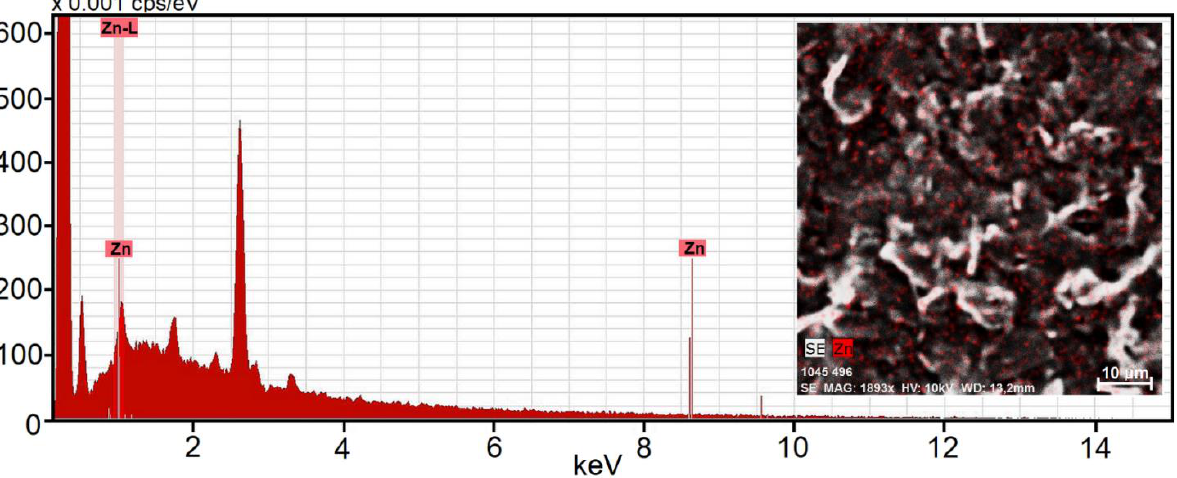
Figure 5. Energy dispersive X-ray spectrum of the screen-printed carbon electrode (type DRP-C110) covered with a thin layer of poly-4-hydroxybenzaldehyde and covalently bound ALP. The inset im- age shows a map of zinc’s distribution throughout the polymer